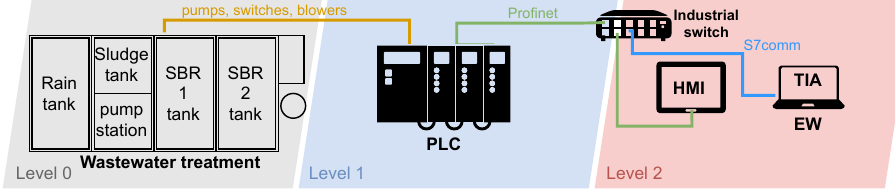
Figure 5. Diagram of wastewater treatment